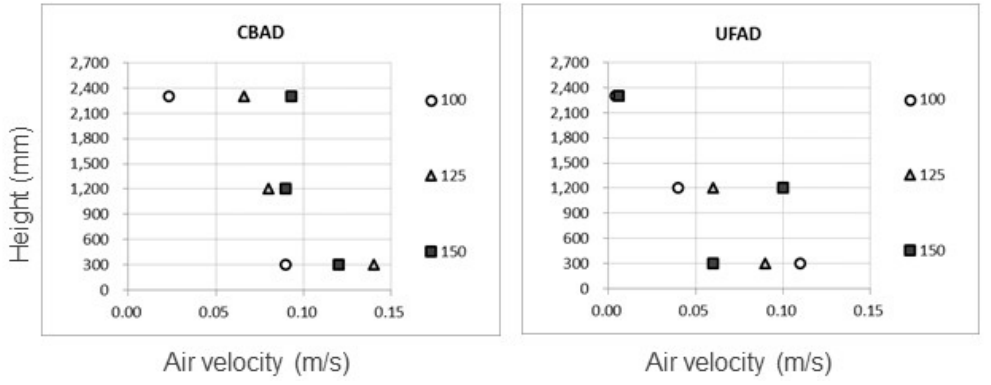
Figure 21. Air current velocity distributions at (X1, Y2): ( left ) CBAD, ( right ) UFAD.